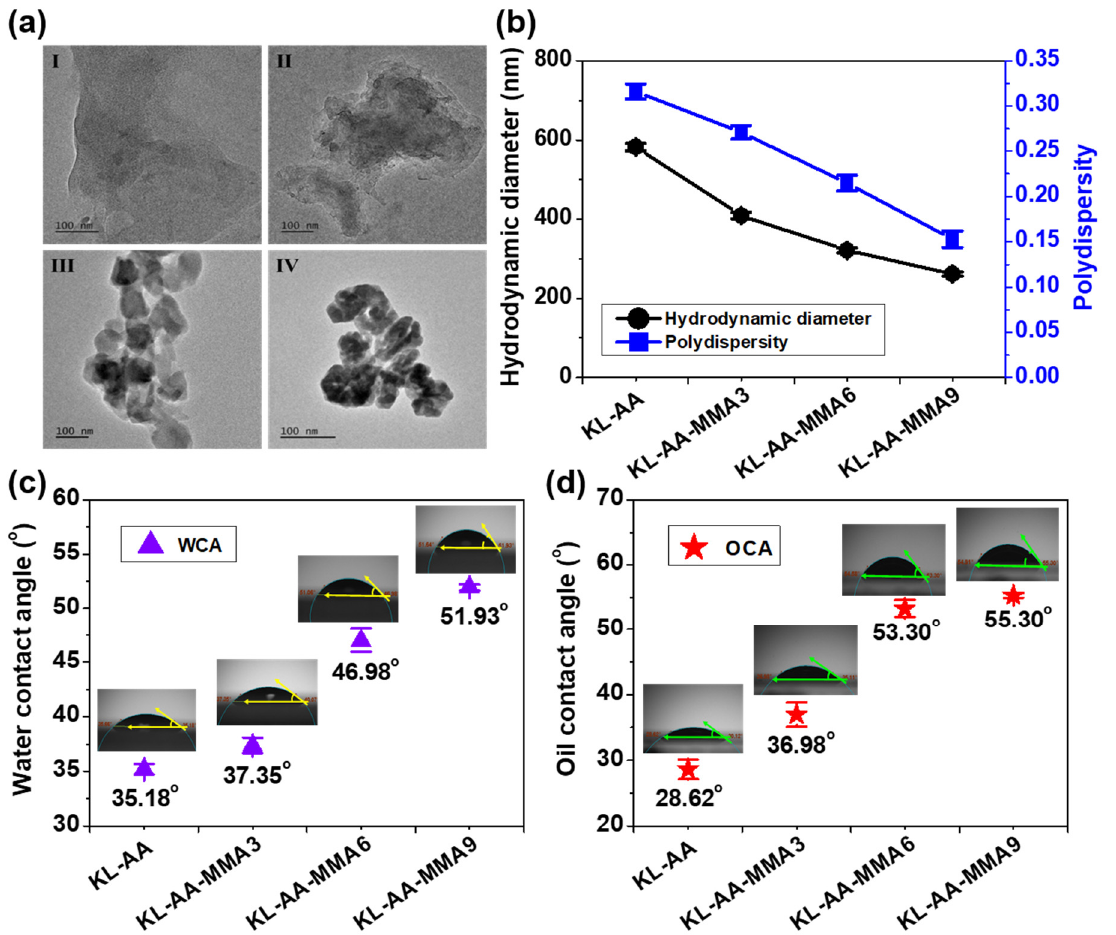
Figure 4. ( a ) TEM images of ( I ) KL-AA, ( II ) KL-AA-MMA3, ( III ) KL-AA-MMA6, and ( IV ) KL-AA- MMA9 nanoparticles. ( b ) Hydrodynamic diameter and polydispersity, ( c ) water and ( d ) oil contact angles of various KL-AA-MMA nanoparticles.